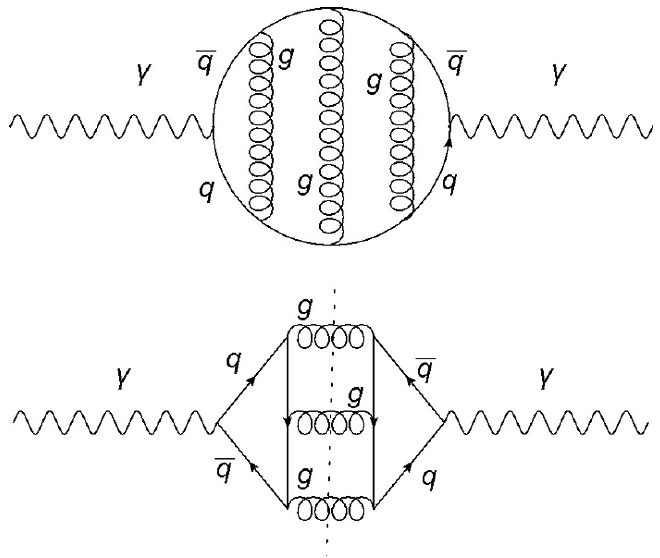
Figure 1 . Examples of a connected (top) and a disconnected (bottom) Feynman